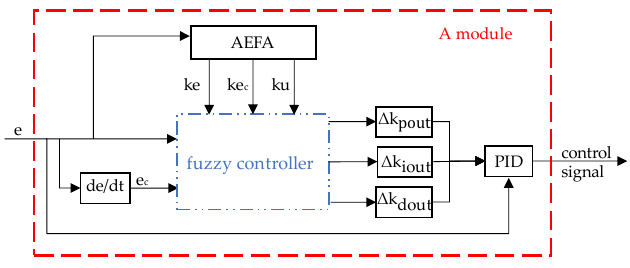
Figure 8. Block diagram of the fuzzy PID – AEFA controller.